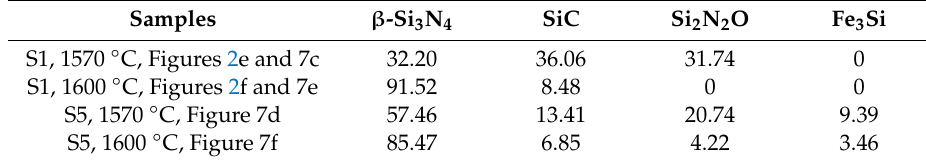
Figure 3. SEM images and X-ray spectroscopies (EDS) patterns of sample S1 nitrided at different temperatures for 3 h: ( a , b )1500 °C, ( c , d ) 1550 °C, ( e , f ) 1570 °C ( g , h ) 1600 °C.